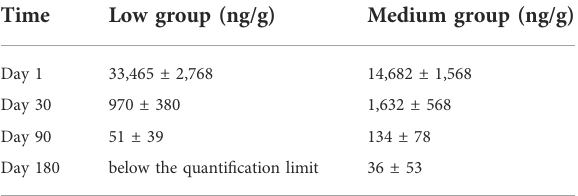
TABLE 2 Paclitaxel concentration in the treated